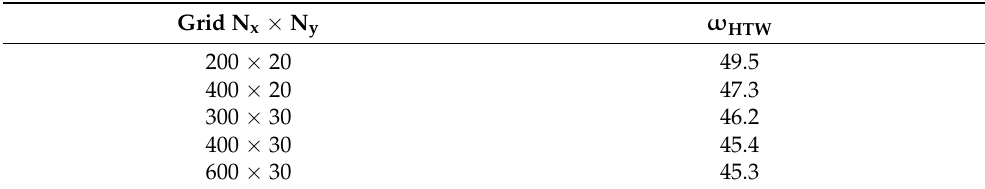
Table 1. Grid refinement study: angular frequency of the hydrothermal wave as a function of mesh resolution (Pr = 15, A = 20, Ma = 2 × 10 4 ).